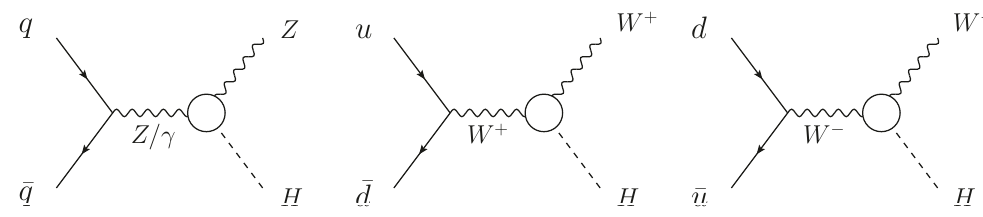
Figure 2 . Feynman diagrams for the sub-processes q (cid:22) q circles denote the non-standard couplings derived from the e(cid:11)ective Lagrangian in eq.